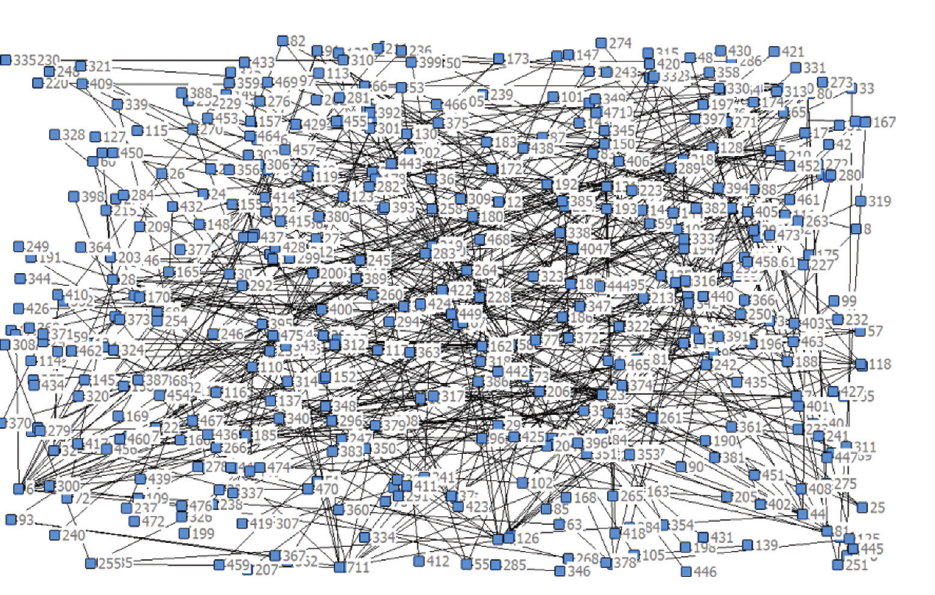
Figure 2. Topology Structure of the